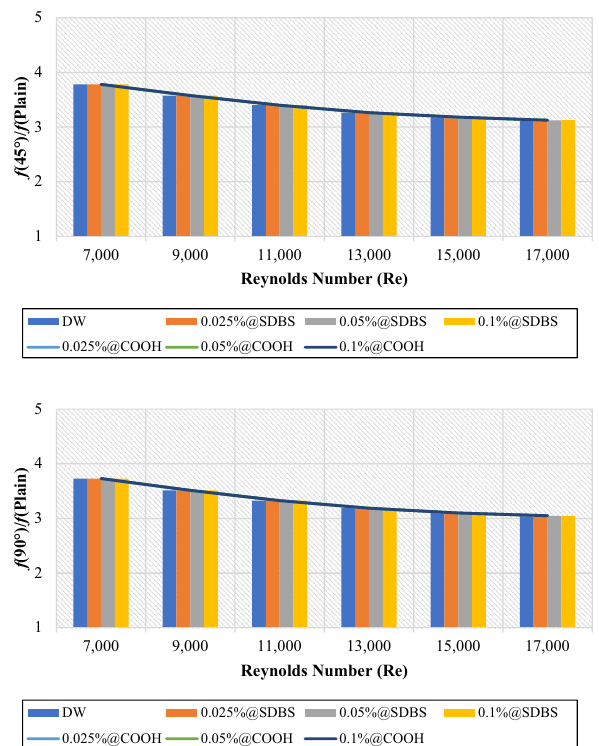
Figure 13. Friction factor of (45° and 90° helix angles) relative to plain pipe versus Reynolds numbers for different